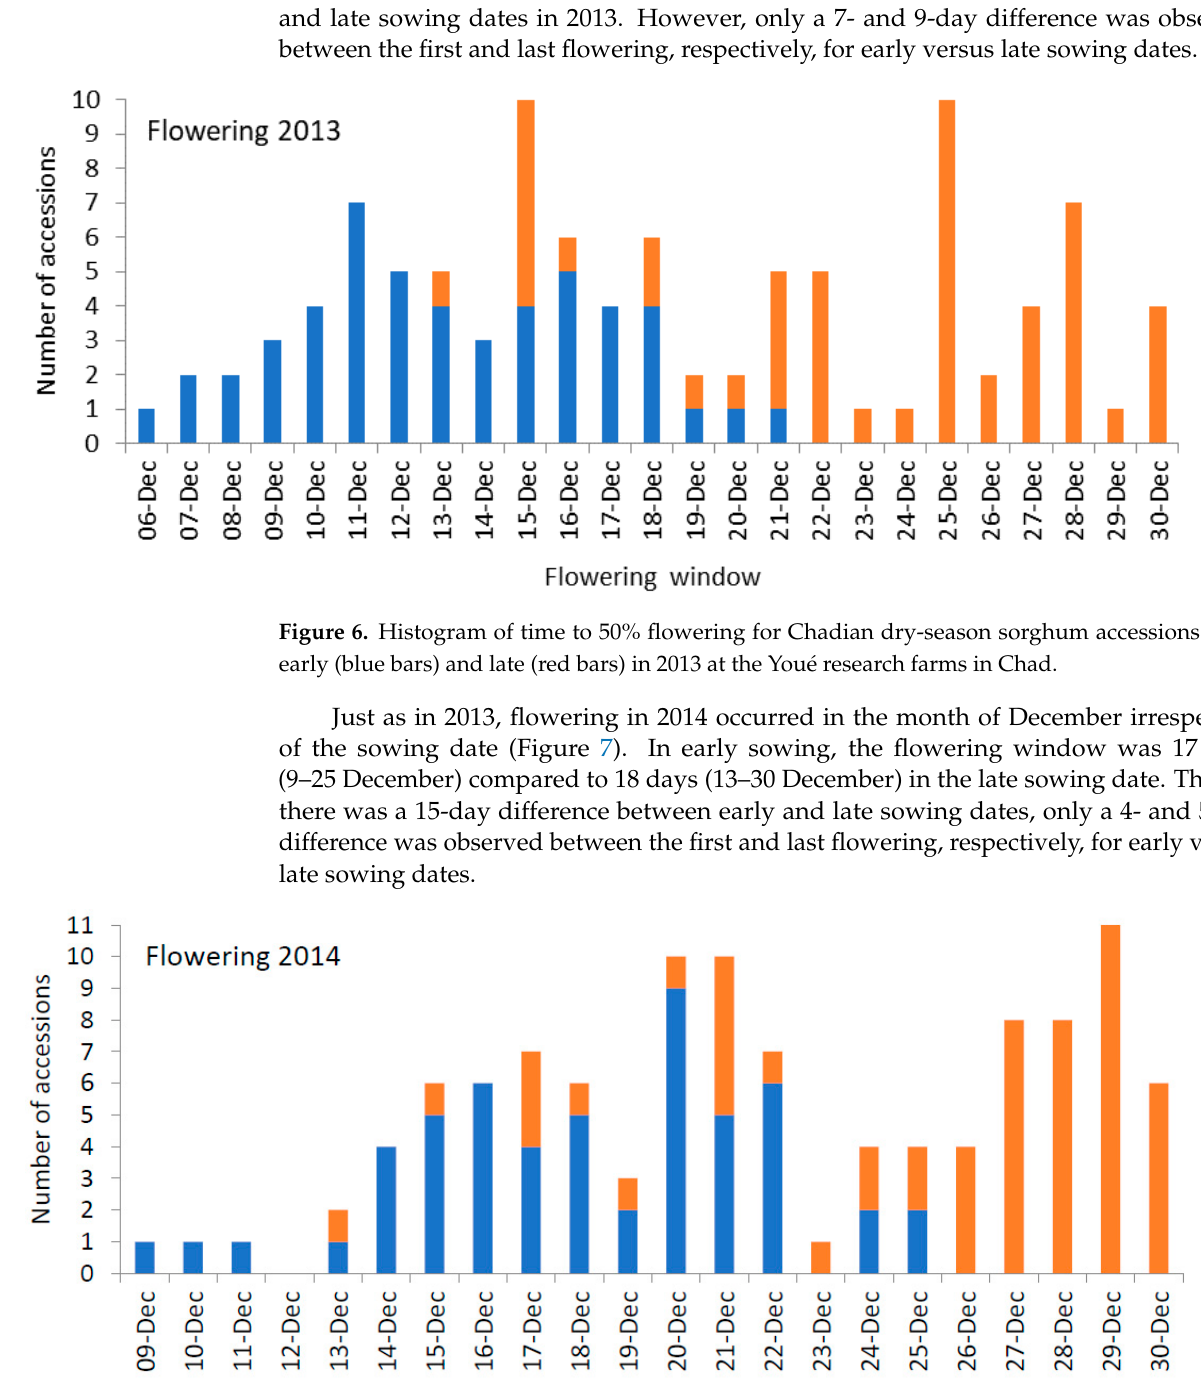
9 of 17 Figure 5. Photoperiod sensitivity index for Chadian dry-season sorghum accessions sown at the Youé research farms in Chad in 2013 and 2014. 3.3. Flowering Time, Day Length, Temperature, and Growing Degree Units 3.3.1. Flowering Window In 2013, fl owering (50% anthesis) occurred in the month of December (Figure 6). For the early sowing date, the fl owering window was 16 days (6–21 December), and 18 days